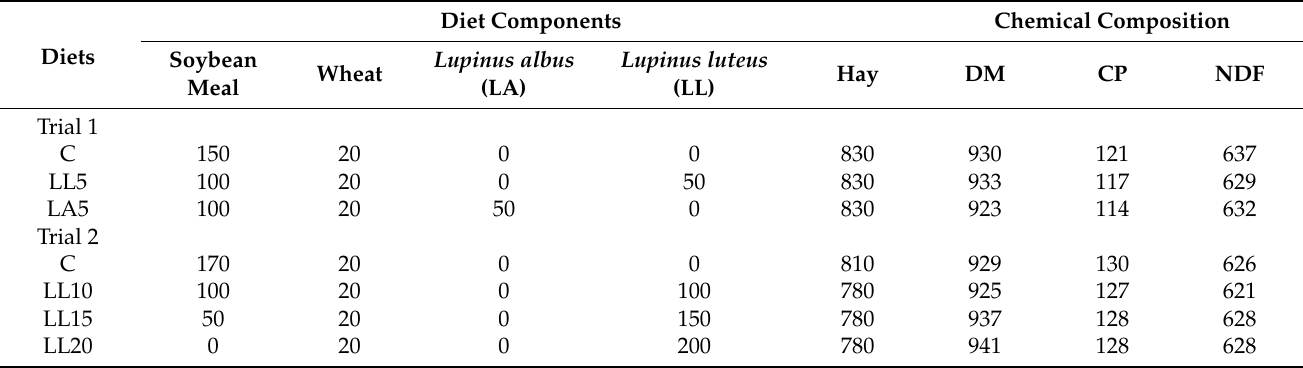
C—control; LL5— Lupinus luteus 50 g/kg; LA5— Lupinus albus 50 g/kg; LL10— Lupinus luteus 100 g/kg; LL15— Lupinus luteus 150 g/kg; LL20— Lupinus luteus 200 g/kg; DM—dry matter; CP—crude-protein; NDF—neutral detergent fiber. Table adapted from Almeida et al.